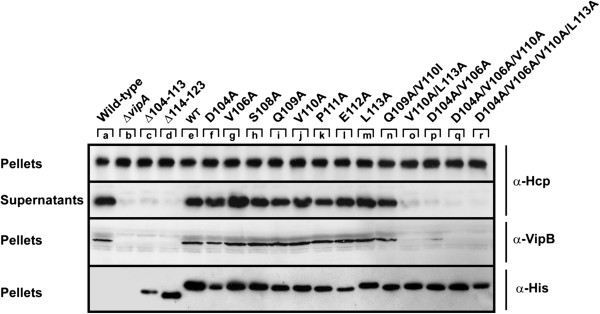
The influence of vipA mutations on VipB synthesis and Hcp synthesis/secretion. Deletion mutant alleles (lanes c-d), wild-type (lane e) or substitution mutant alleles (lanes f-r) of vipA were expressed from the ptac promoter of pMMB66EH in a vipA null mutant background. Hcp protein contained in the pellet fraction or secreted to the culture medium was separated by SDS-PAGE and identified by immunoblot analysis using antiserum specific for Hcp. For detection of intrabacterial VipB and VipA, anti-VipB and anti-His antisera were used respectively. The experiment was repeated at least three times and a representative example is shown.